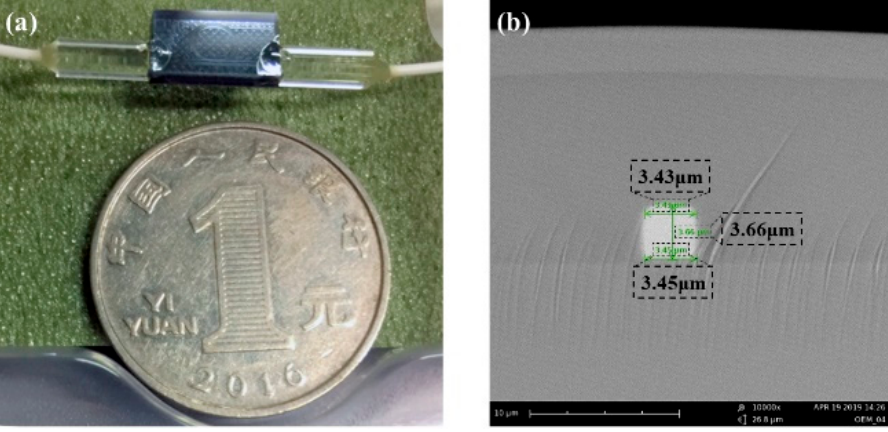
Figure 7. ( a ) Microring resonator (MRR) after package process. ( b ) The scanning electron microscope (SEM) photo of the core waveguide cross